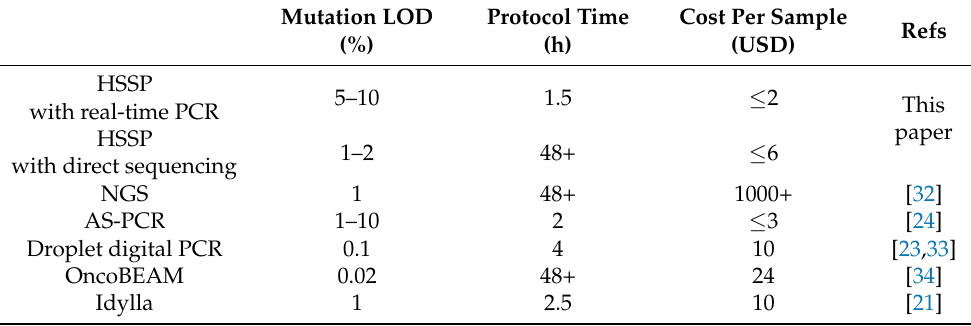
Table 2. Comparison of mutation detection technologies for KRAS mutation. Mutation LOD Protocol Time Cost Per Sample (%) (h) (USD) HSSP with real-time PCR paperHSSP 1–2 48+ with direct sequencing